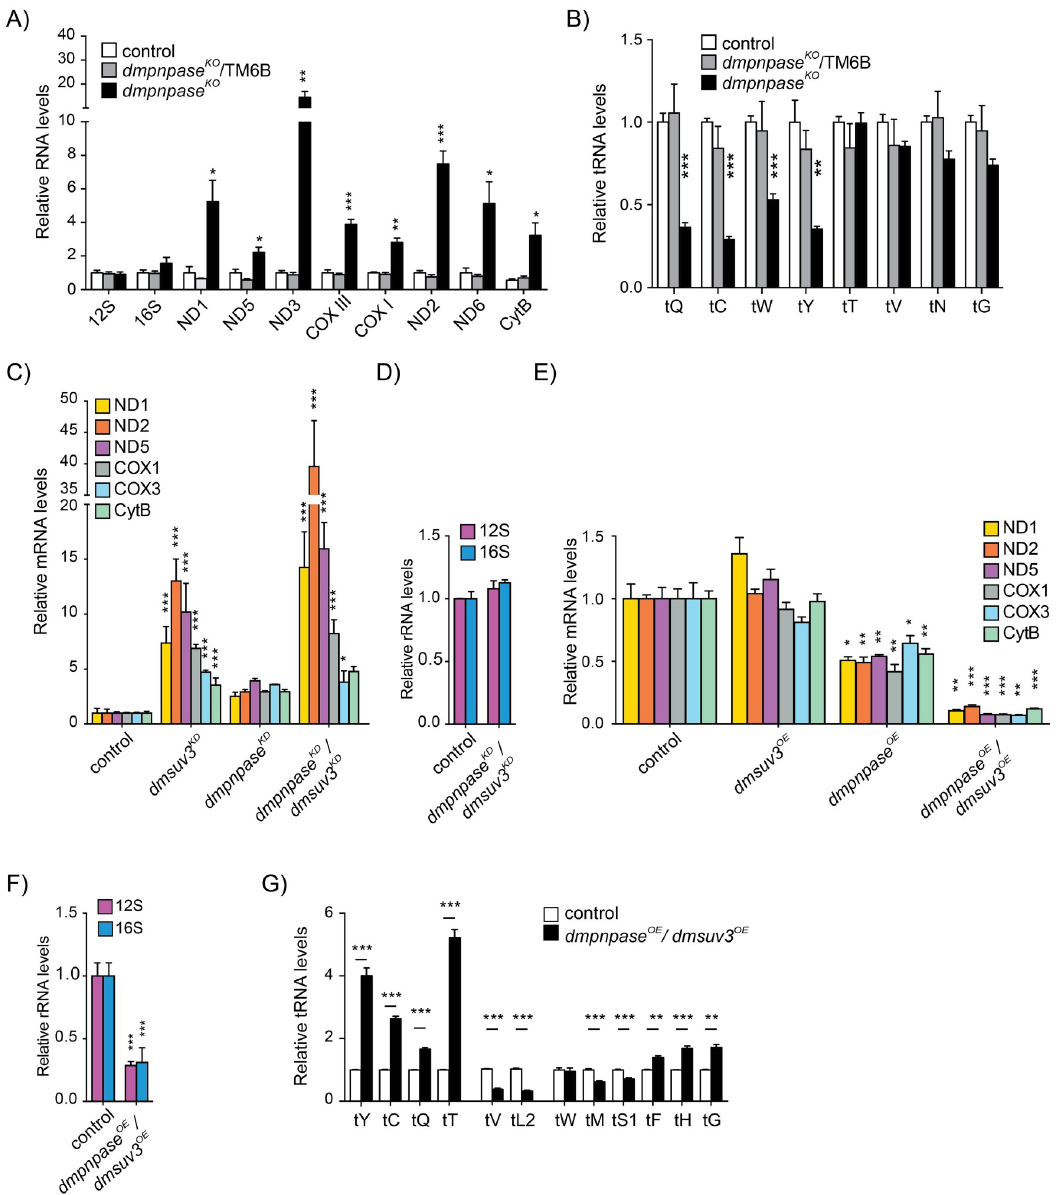
Fig 2. DmPNPase modulates the stability of mt-mRNAs. ( A ) Mitochondrial mRNA steady-state levels in dmpnpase KO and its controls (control 1: w;;daGAL4/+ and control 2: w;; dmpnpase KO /TM6B) at 4 days AEL by qRT-PCR. RP49 transcript was used as an endogenous control. ( B ) Quantification of mitochondrial tRNA steady-state levels from Northern blotting analysis in S3B. Cytosolic tRNA Val was used to normalise the quantification. ( C ) Mitochondrial mRNA steady-state levels in DmSUV3 KD (w;UAS- dmsuv3 RNAi/+;daGAL4/+), dmpnpase KO , (w;UAS- dmpnpase RNAi;daGAL4/+) dmpnpase KO / dmsuv3 KD (w;UAS- dmsuv3 RNAi/ UAS- dmpnpase RNAi;daGAL4/+) and control (w;;) larvae at 4 days AEL, as determined by qRT-PCR. RP49 transcript was used as an endogenous control. ( D ) Mitochondrial rRNA steady-state levels in dmpnpase KO / dmsuv3 KD determined by Northern blotting. RP49 transcript was used as an endogenous control for normalisation. ( E ) Mitochondrial mRNA steady-state levels in dmpnpase OE (w;; UAS- dmpnpase /daGAL4), dmsuv3 OE (w;UAS- dmsuv3 /+;daGAL4/+), dmpnpase OE / dmsuv3 OE (w;UAS- dmsuv3 /+;UAS- dmpnpase / daGAL4) and control (w;;) larvae at 4 days AEL, as determined by qRT-PCR. RP49 transcript was used as an endogenous control. ( F ) Mitochondrial rRNA steady-state levels in dmpnpase OE / dmsuv3 OE larvae determined by qRT-PCR. ( G ) Northern blot quantification of the steady-state levels of mitochondrial tRNAs in dmpnpase OE / dmsuv3 OE and control (w;;) larvae at 4 days AEL. Loading of the gel was normalised and quantified using a probe against cytosolic tRNA Val . All data is represented as mean +/- SEM ( ��� p < 0.001, �� p < 0.01, � p < 0.05, n = 5).